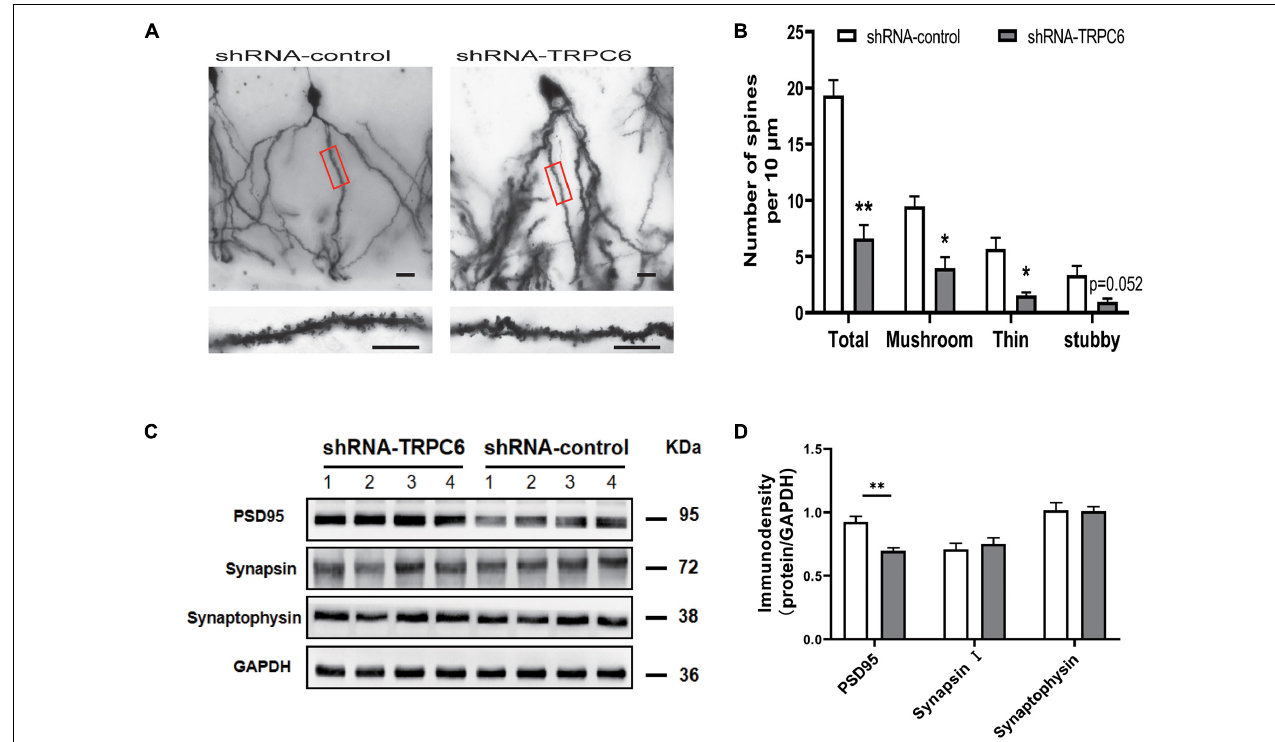
FIGURE 8 | Dendritic spines of DG neurons and PSD95 in hippocampus in shRNA-TRPC6 treated mice were significantly decreased. (A) Photomicrographs of DG neurons dendrites taken at 20x power, dendritic branches in red panels are magnified at 100x power. (B) Quantification of dendritic spines of DG neurons per 10 µ m branch showing decreased spine density in the shRNA-TRPC6 treated mice, quantification of each spine type showing immature development trend in shRNA-TRPC6 mice ( n = 3, 3, t -test). (C,D) Down-regulation of TRPC6 decreased the levels of PSD95 in hippocampus extracts measured by western blotting and the quantitative analyses ( n = 4 each group). Data were presented as mean ± SEM. * P < 0.05, ** P < 0.01. Scale bars: 40 µ